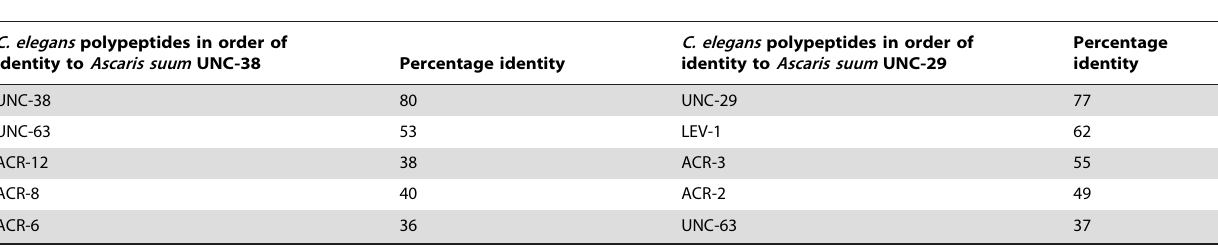
Table 1. Comparison of the amino-acid sequences of A. suum nicotinic receptor subunits with those of C. elegans .